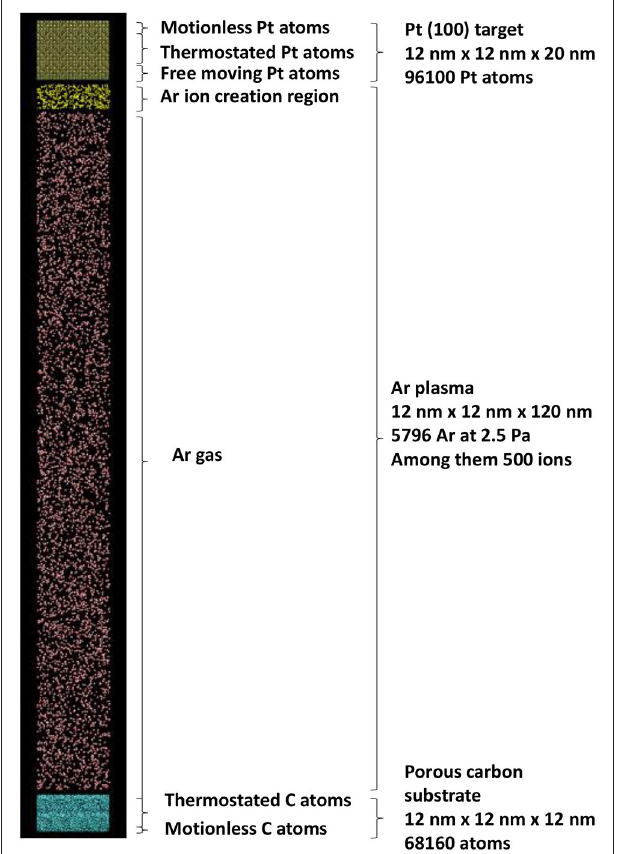
FIGURE 3 | Schematics of the simulation cell with the initial positions of all species involved in sputtering plasma